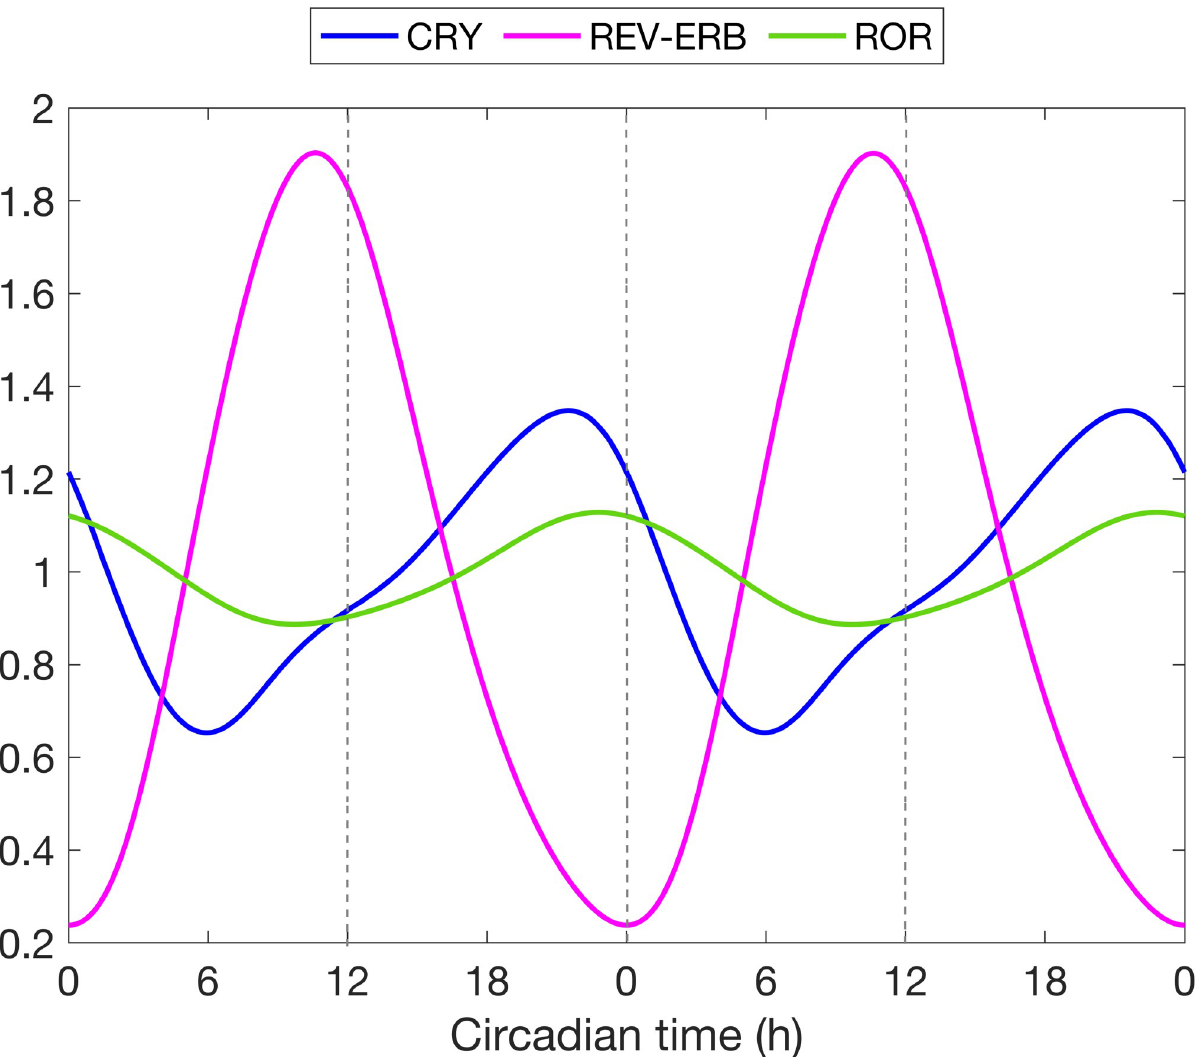
Fig 6. Phase relations between CRY, REV-ERB and ROR. Baseline model simulation of the main clock genes involved in the inflammatory response. Normalized temporal expression profiles of CRY, REV-ERB and ROR proteins, relative to their respective mean value.